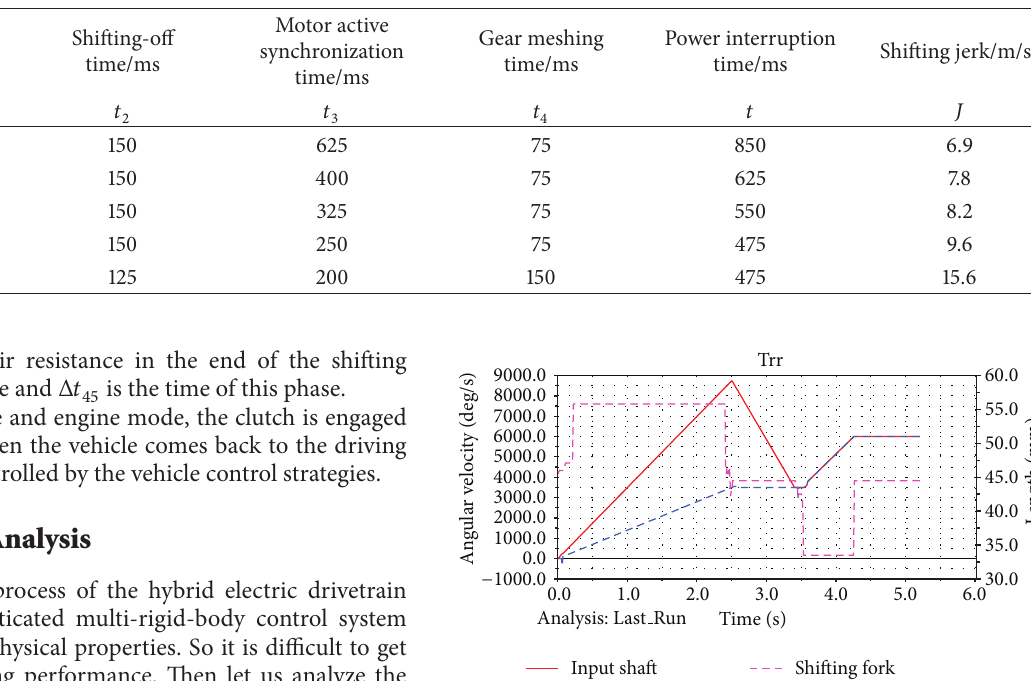
Figure 8: The EMT gear shifting process simulation. Table 1: Simulation results of shifting quality with different motor torques.